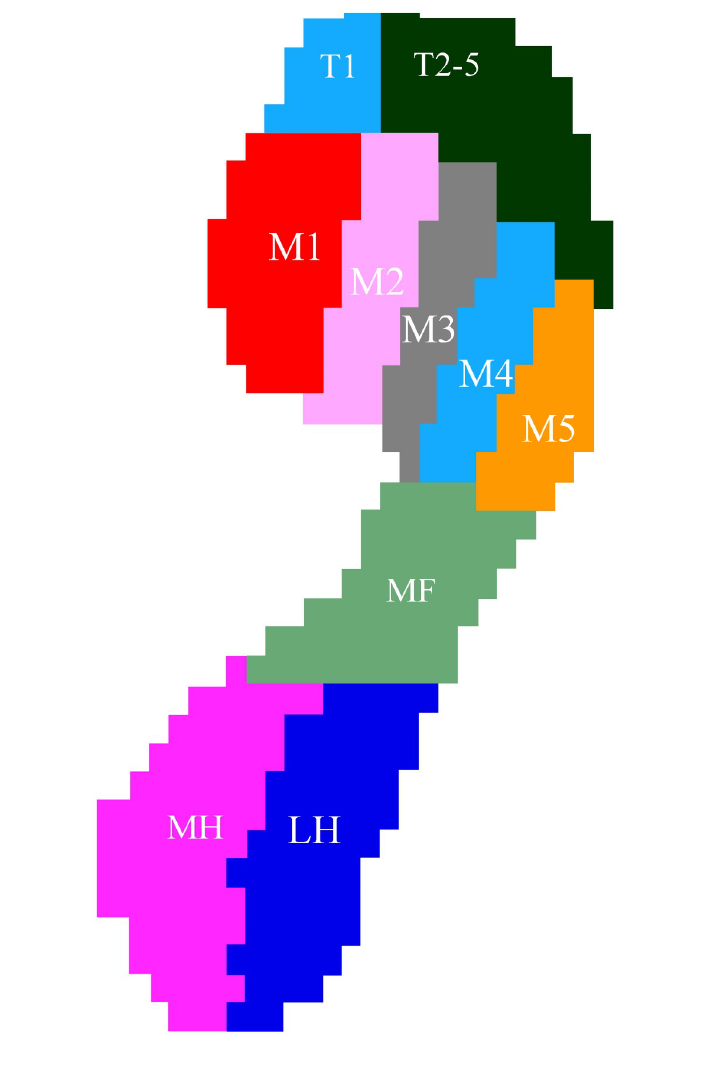
Fig 1. The divided regions of the foot. MH, medial heel; LH, lateral heel; MF, middle foot; M1-M5, 1st metatarsal to 5th metatarsal; T1, first big toe; T2-T5, 2nd toe to 5th